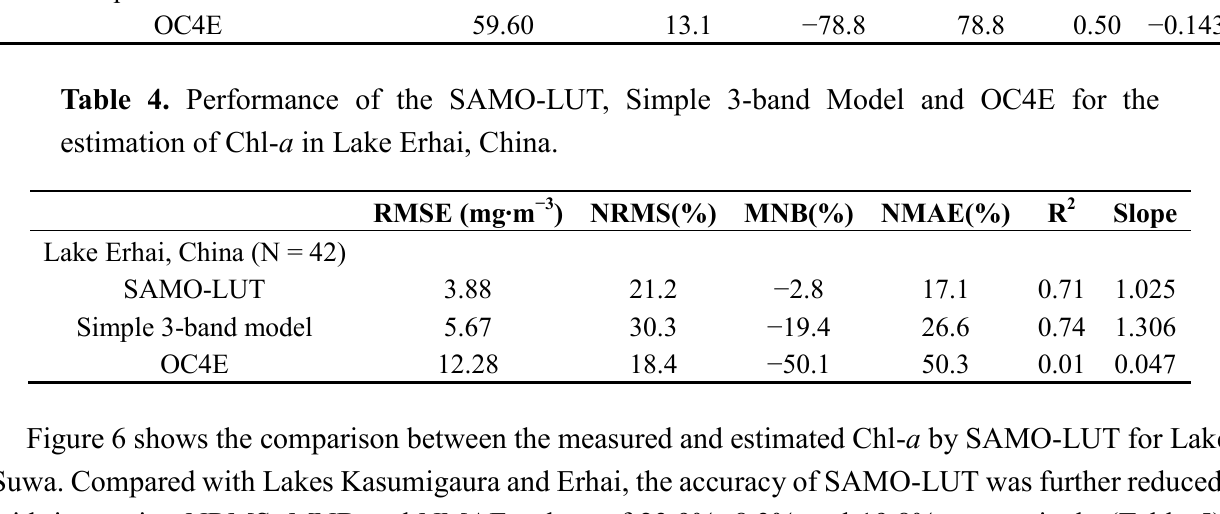
Lake Erhai, China